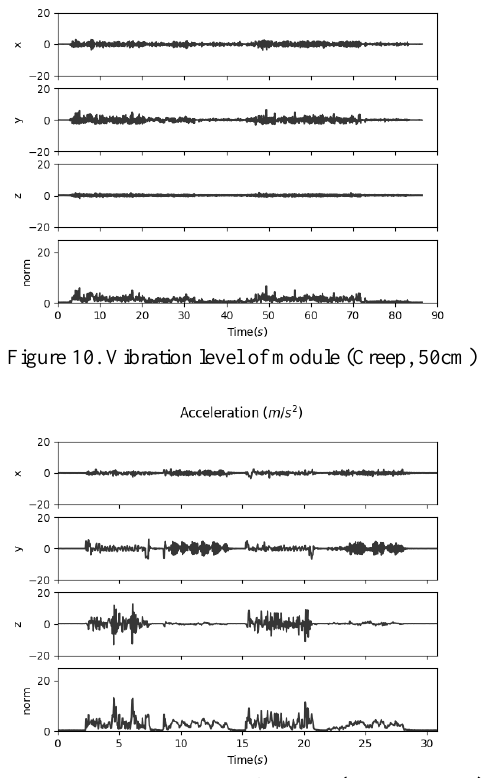
Figure 7. Vibration level of module (Normal, 15cm)